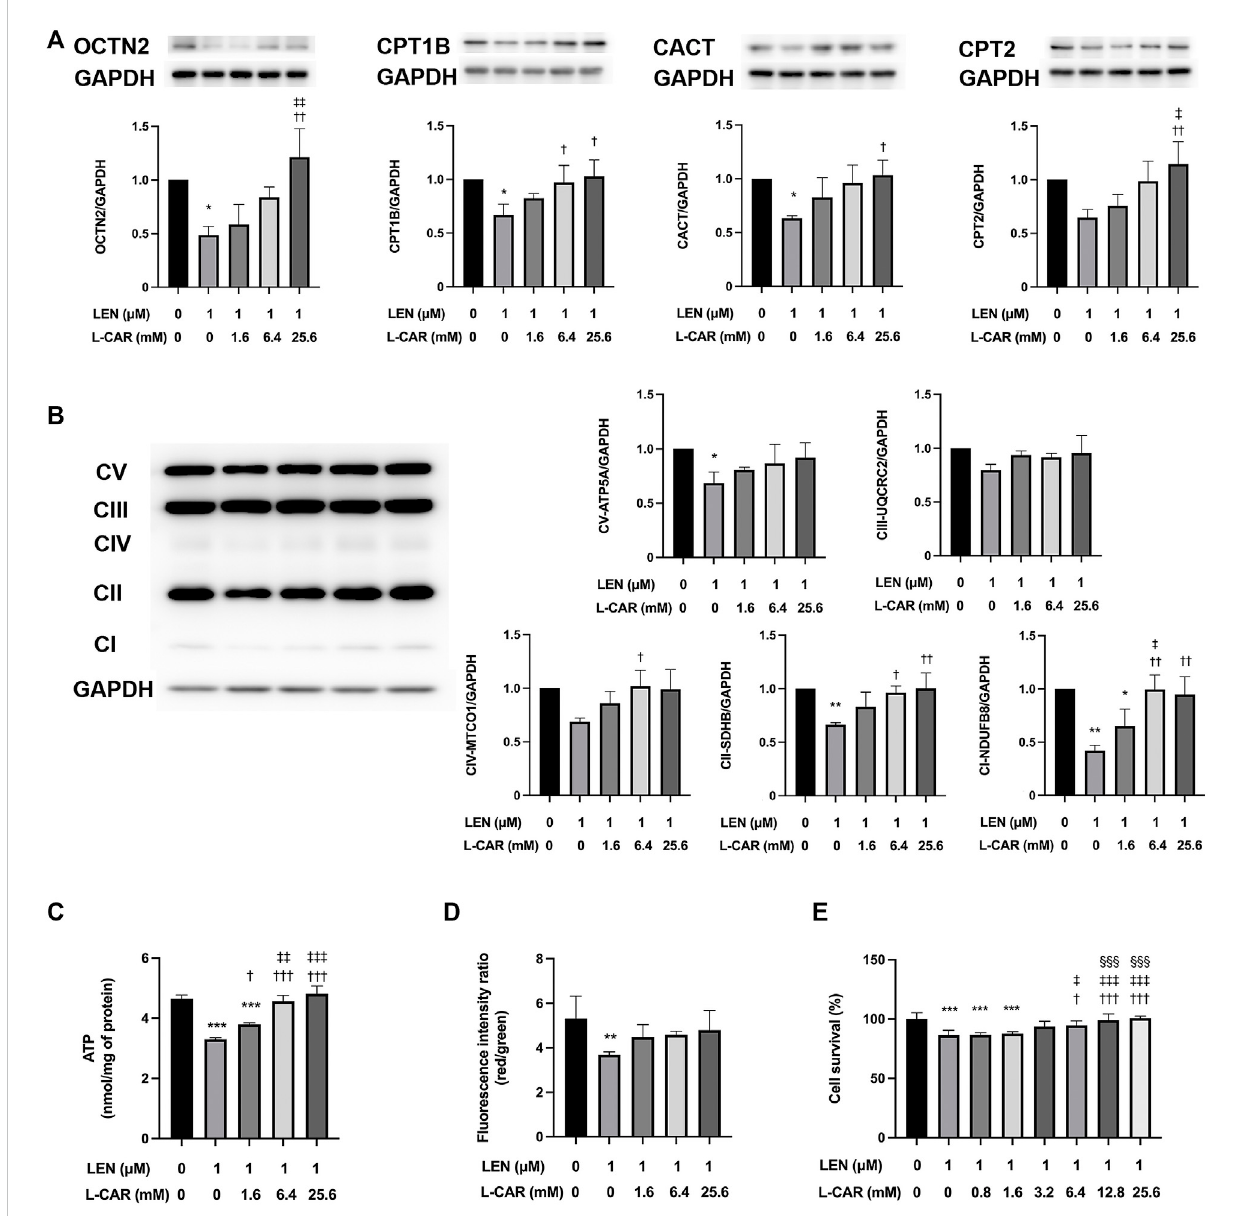
FIGURE 5 Effects of L-carnitine on carnitine-related and OXPHOS protein expression and mitochondrial function in lenvatinib-treated C2C12 myocytes. Differentiated C2C12myocytesweretreatedwithlenvatinib(1 µM),L-carnitine(1.6,6.4,or25.6 mM),orvehiclefor24 h.Thereafter,theexpressionlevels of carnitine-related (A) and oxidative phosphorylation (OXPHOS) proteins (B) , adenosine triphosphate (ATP) content (C) , mitochondrial membrane potential (D) , and cell survival (E) were measured in the cells. The upper panel in Fig. A and left panel in Fig. B represent the results of three independent experiments. Data are presented as the mean +SD ( n = 3 for panels (A – C) ; n = 5 for panel (D) ; and n = 6 for panel (E) . * p < 0.05, ** p < 0.01, *** p < 0.001 vs . Ctrlgroup; † p < 0.05, †† p < 0.01, ††† p < 0.001 vs. LENalone group; ‡ p < 0.05, ‡‡ p < 0.01, ‡‡‡ p < 0.001 vs. LEN+ thelowest-dose L-CAR